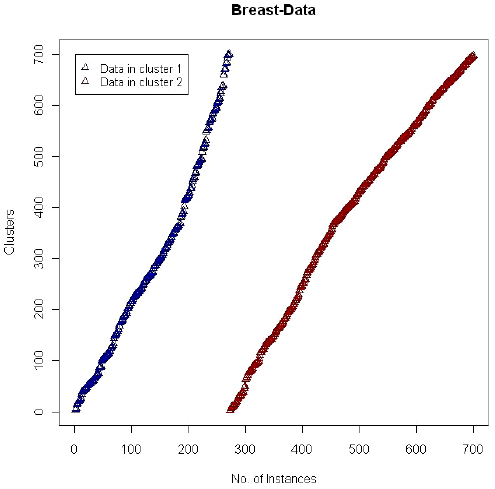
Fig. 26. Size of clusters by KEFCM wd .